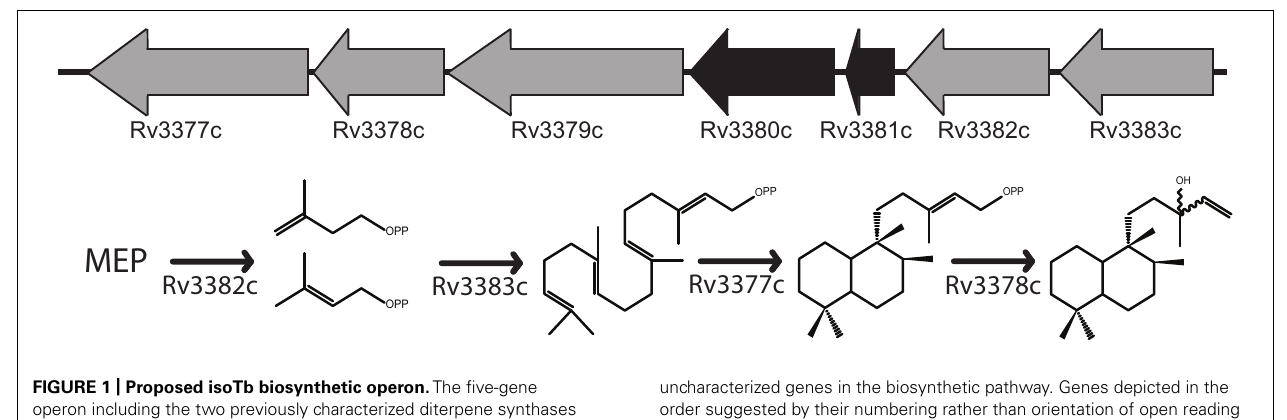
FIGURE 1 | Proposed isoTb biosynthetic operon. The five-gene operon including the two previously characterized diterpene synthases required for isoTb biosynthesis and the proposed roles of the remaining